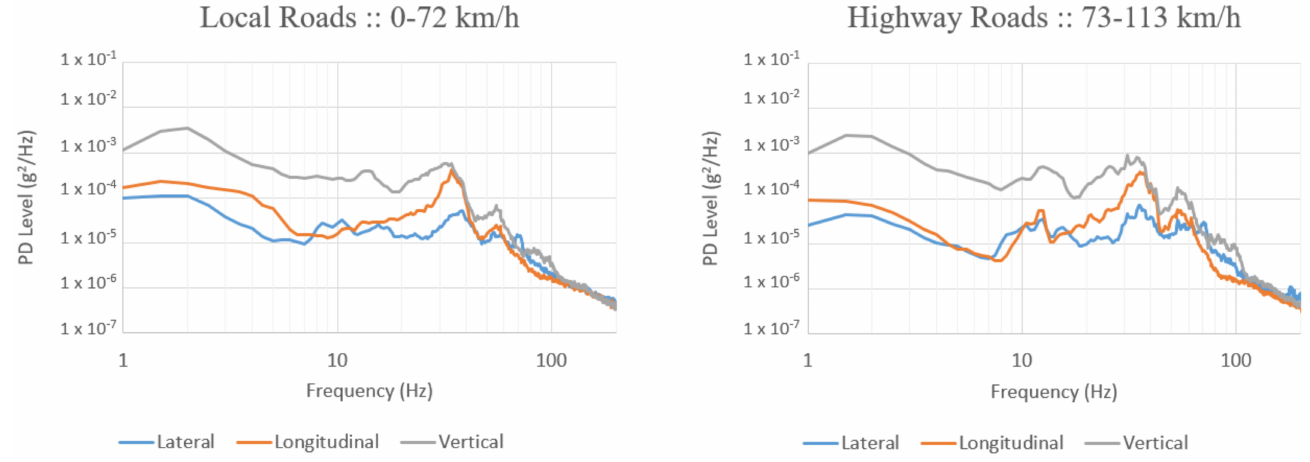
Figure 5. PSD plots for triaxial vibration of the Pilot full-size SUV. Table 2. Vehicle measurements and